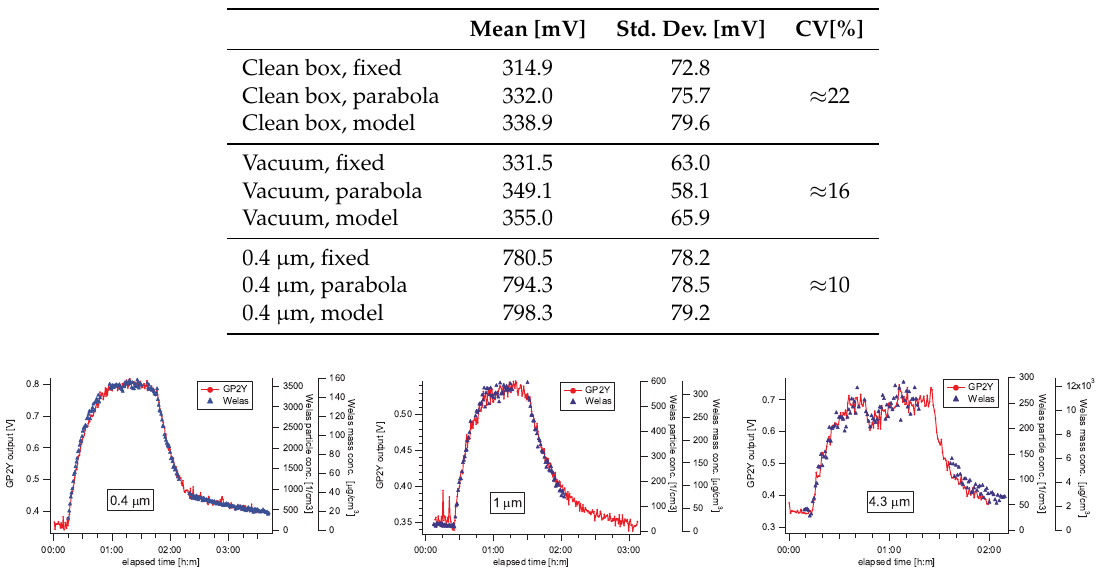
Figure 6. Pulse heights were determined with three different methods: with the recommended fixed-time offset, with fitting parabola over three highest points and with fitting the model function. The parameters of the distributions are gathered in Table 1. ( Left ) pulse height distributions in a clean box ( n < 10 part./cm 3 ) and in a low-pressure chamber ( p ≈ 20 mbar). Histograms include approx. 40,000 pulses each. ( Right ) pulse height distributions in a stable atmosphere with approx. 3500 particles per cubic centimeter dispersed in air. PSL particles of size 0.4 µ m were used. Histograms include approx. 8000 pulses each. The duration of the measurement was about half an hour. See also the corresponding leftmost time graph in Figure 7. Table 1. Parameters to describe the data in Figure 6.